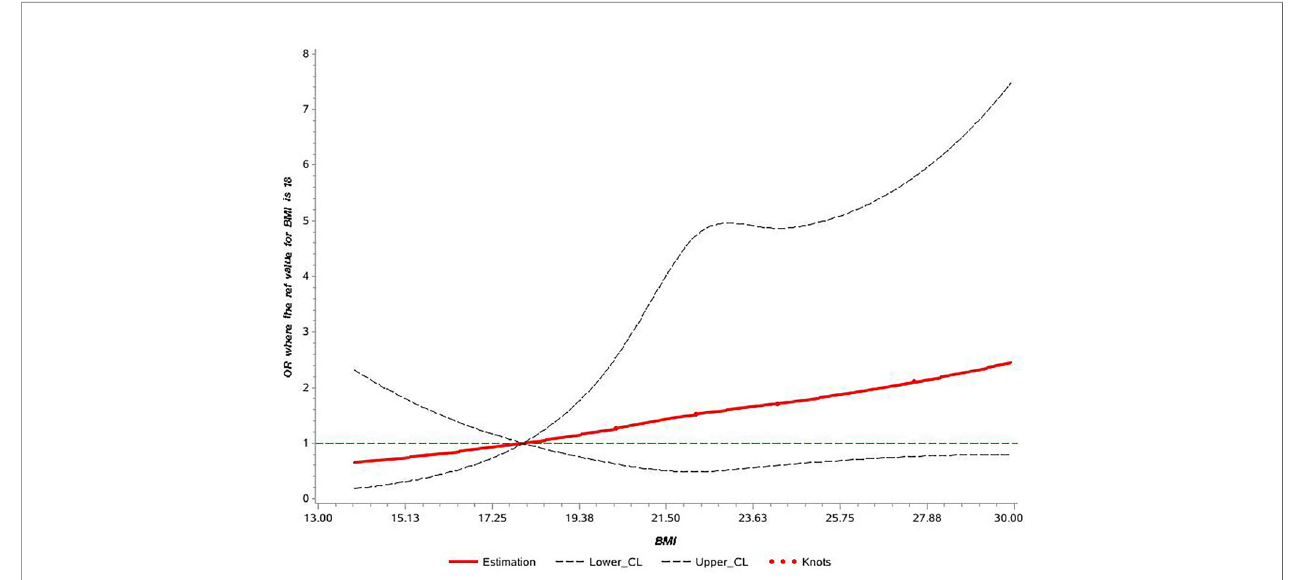
FIGURE 2 | Cubicspline graphof the adjustedoddsratio(OR)(shown insolid line) and95% CI (the dottedlines) for the association between bodymass index (BMI) and risk of early-onset colorectal neoplasmin Shanghaicolorectal cancer (CRC)screeningcohort, 2012-2016. Knots: 18, 24, and 28 ofBMI (kg/m 2 );Referent: 18 kg/m 2 .